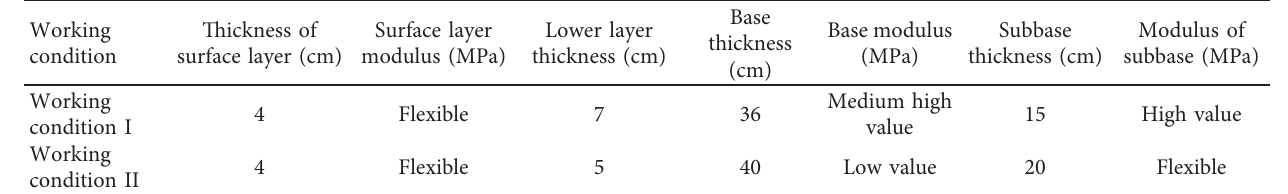
Table 6: Recommended pavement